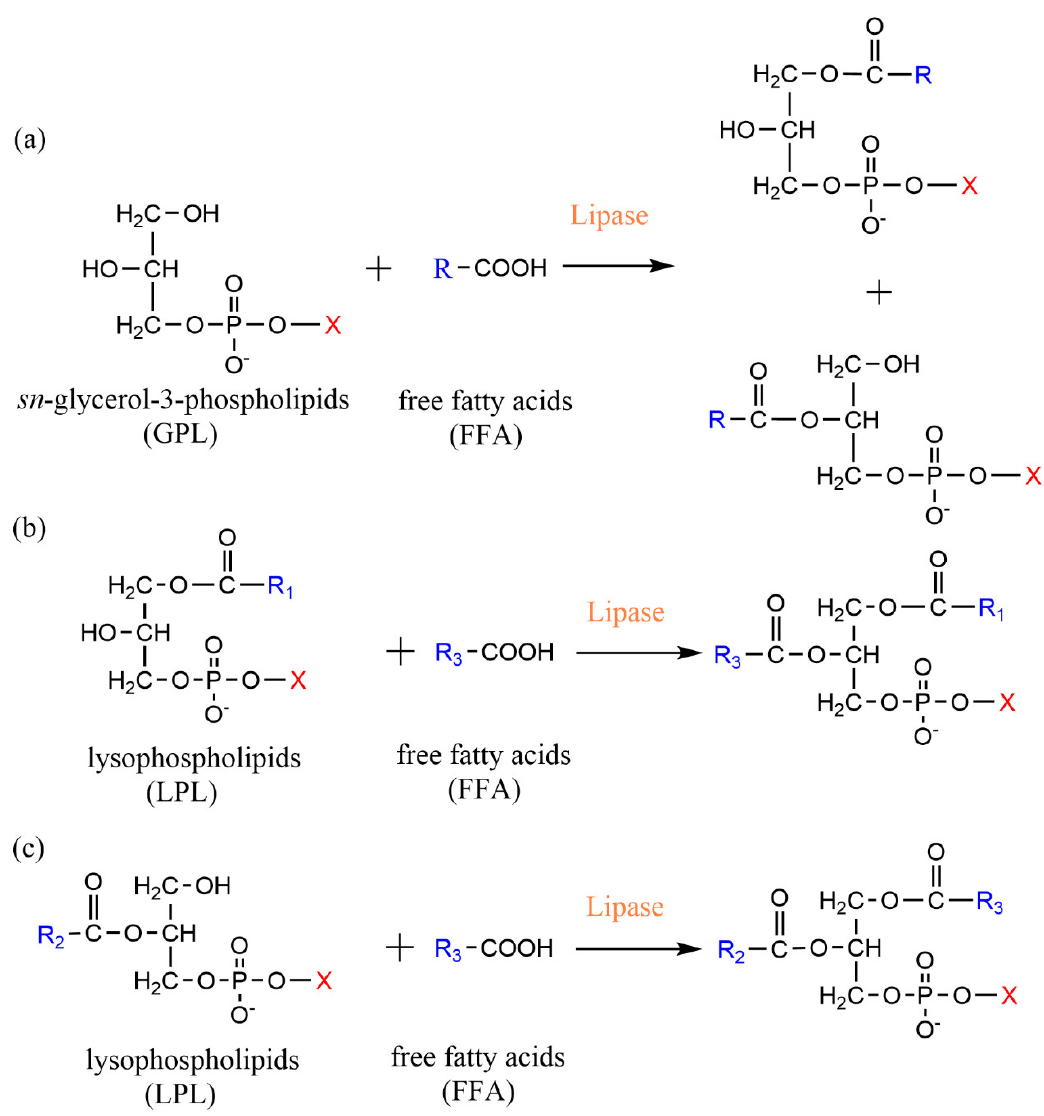
Figure 2. Lipases catalyze the esterification between sn –glycerol−3−phospholipids (GPL) ( a ) or lys−phospholipids (LPL) ( b , c ) and free fatty acid (FFA) to produce corresponding SPLs.